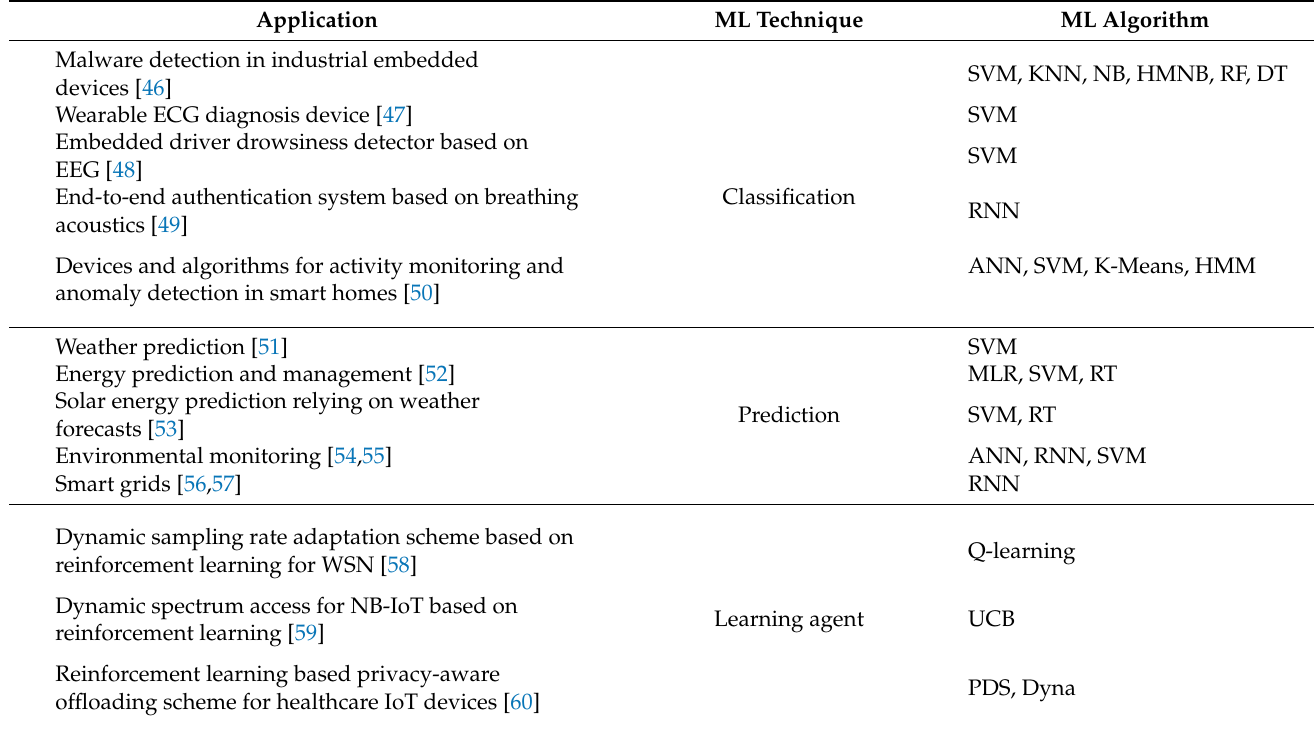
Table 1. ML algorithms used in internet of things (IoT)